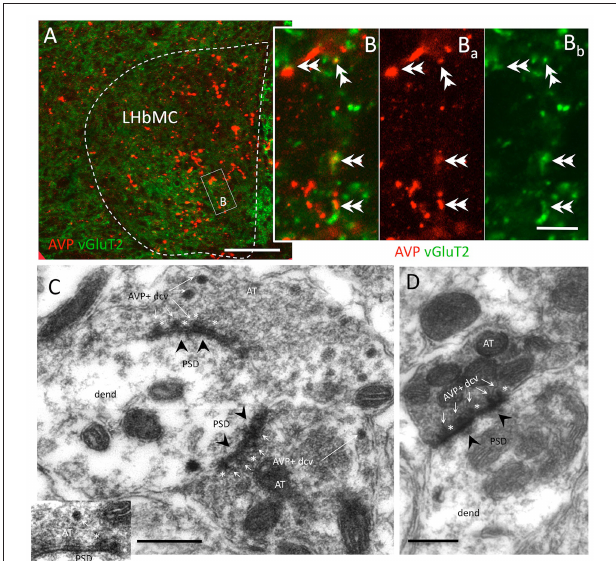
FIGURE 2 | Most AVP + axon terminals co-expressed vesicular glutamate transporter 2 (vGluT2) and established Gray type I synapses onto habenular neuron’s dendrites. (A,B) Representative confocal photomicrographs of double immunofluorescence AVP (red) and vGluT2 (green) centered at the medio-central lateral habenular (LHbMC) subnucleus. Double arrowheads indicate the double-labeled axon terminals. (C,D) Electron microscopy photomicrographs showing the AVP + dense core vesicles (dcv, thin white arrows) inside the axon terminals (AT) established Gray type I synapse (post-synaptic densities, PSD, were indicated with black arrowheads) onto habenular neuron’s dendrites (dend). Asterisks are put adjacent to AVP+ dcv, which showed docking onto presynaptic membranes. Scale bars: A : 50 µ m; B : 5 µ m, C , D : 500nm.